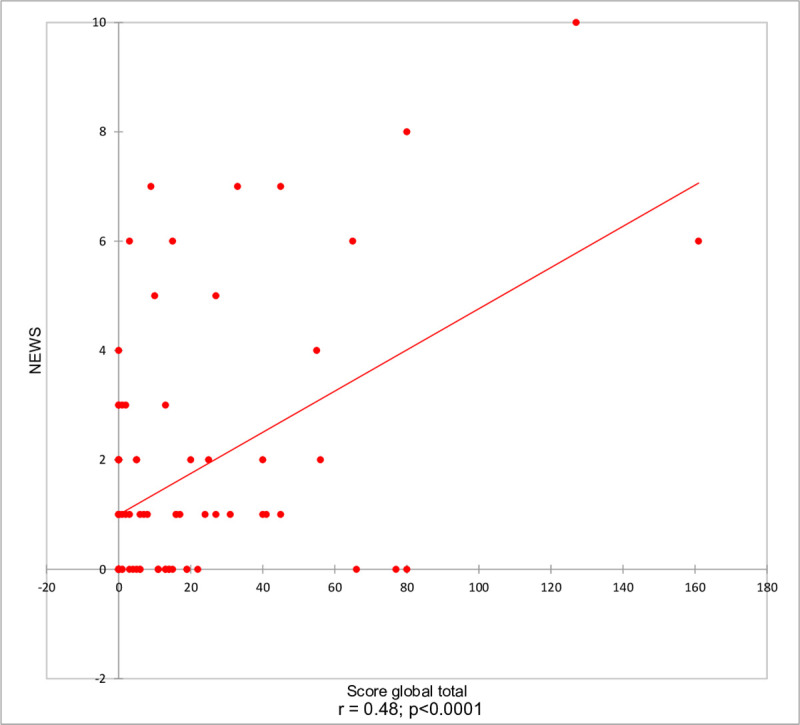
Correlation between the NEWS and COVID19-LDCT score.A significant correlation was found. Pearson coefficient = 0.48; p < 0.001.